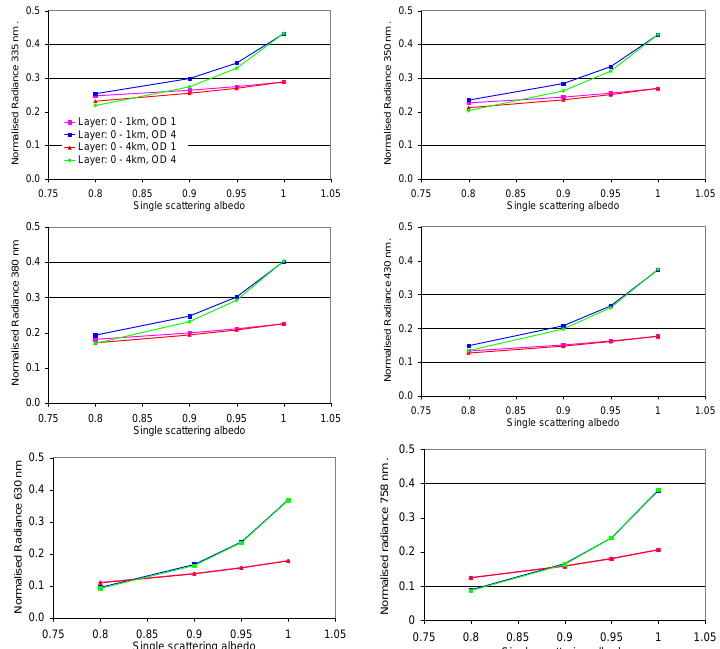
Fig. A7 Dependence of the normalised radiance on the aerosol single scattering albedo. The calculations are performed for SZA of 30° and a viewing angle of -90° (nadir geometry). The aerosol asymmetry parameter was assumed to be 0.68. For 758 nm the surface albedo was set to 20%, for 630 nm to 10%, and for all other wavelengths to 5%.